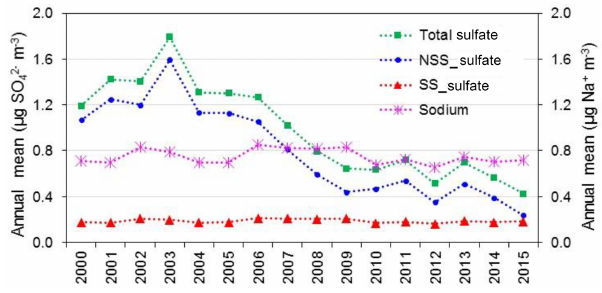
Figure 17. Comparison of long-term trends in annual mean concen- trations of total sulfate (as determined from the amount of sulfate collected on the AGANet aerosol filter), nss_sulfate (estimated from the empirical relationship: [nss_SO 4 ] = [SO 2 − ] − (0 . 25 ×[ Na + ] ), 4 ss_sulfate (Total − nss) and sodium. Each data point represents the annually averaged mean concentration of 12 sites for the 16 year period from 2000 to